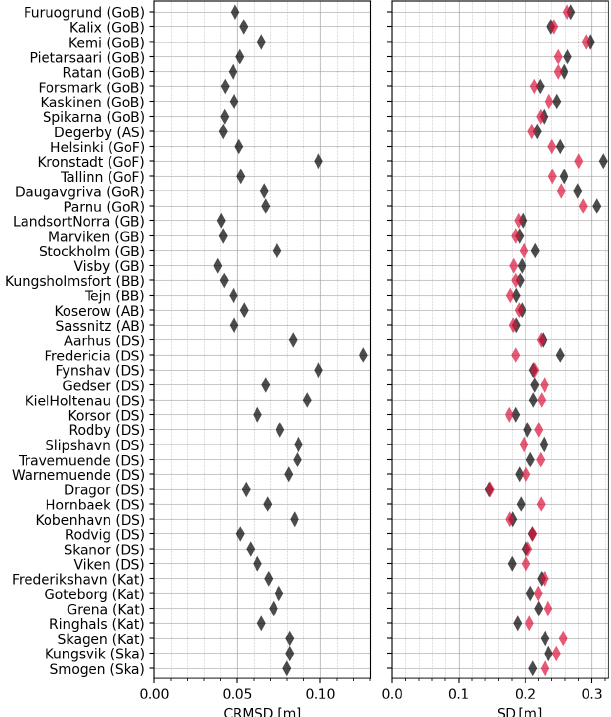
Figure 2. Sea surface height error metrics. Black and red sym- bols denote the model and observations, respectively. See Fig. 1 for station locations. Sub-basins are indicated by the following ab- breviations: GoB, Gulf of Bothnia; AS, Archipelago Sea; GoF, Gulf of Finland; GB, Gotland basin; BB, Bornholm basin; AB, Arkona basin; DS, Danish Straits; Kat, Kattegat; Ska,